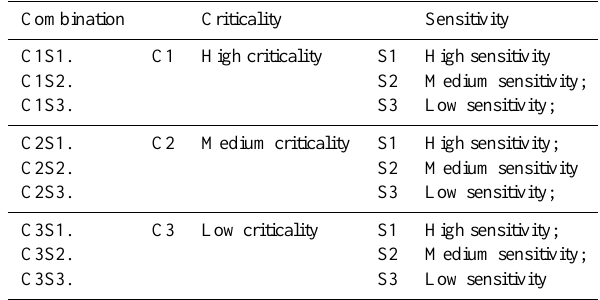
Table 1. The combination of Criticality and Sensitivity in the Re- gional Coastal Plan of